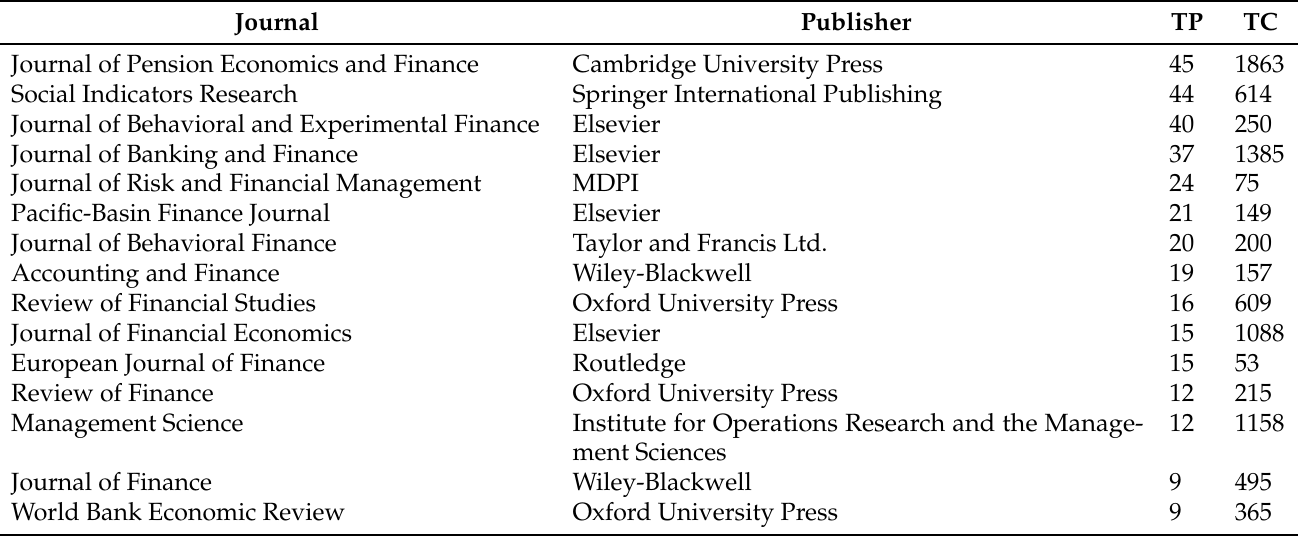
Table 2. Leading journals publishing on financial literacy prepared using VOSviewer software.